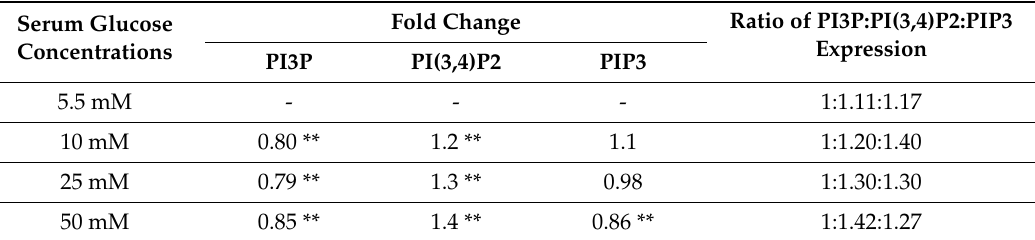
Figure 4. E ff ect of glucose concentration on MCF7 cell surface PI phosphorylation. PI3P, PI(3,4)P2, and PIP3 relative concentrations for MCF7s as determined by fluorescence intensity in fixed cells ( n > 60). The % of total PI lipid for each mono-, di-, and tri-phosphorylated PI was determined through intensity analysis for the MCF7 cell line, incubated at 5.5 ( (cid:3) , blue ), 10 ( (cid:3) , orange ), 25 ( (cid:3) , grey ), and 50 ( (cid:3) r, yellow ) mM serum glucose concentrations, respectively. * denotes p < 0.05 and ** denotes p < 0.005 as determined by a one-way ANOVA pair-wise comparison. Table 3. Analysis of MCF7 cell surface